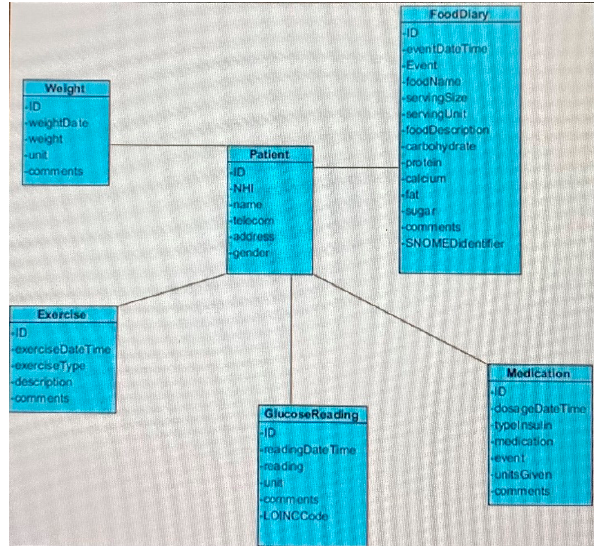
Figure 2. Database schema.